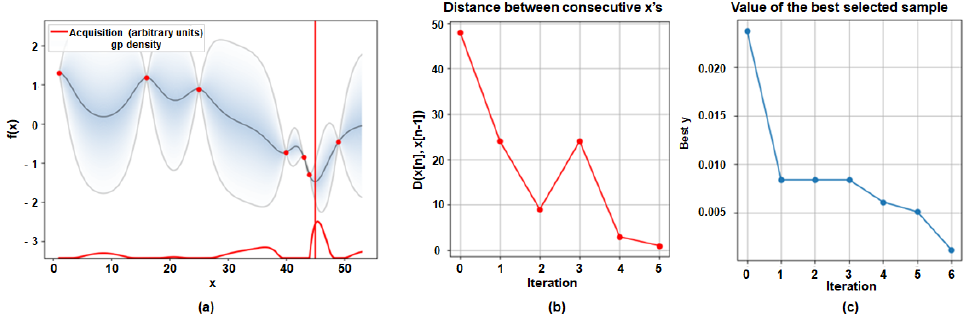
Figure 7. Visualization results of the optimal sharing layer configuration through BayesOpt BayesOpt as threshold accuracy degradation is 2% less than the baseline accuracy. (60 classes/40 classes) ( a ) the result of the selected optimal number of sharing layers. ( b ) The L2 distance of the consecutive observed points. ( c ) The value of the calculated best-selected sample for every iteration.